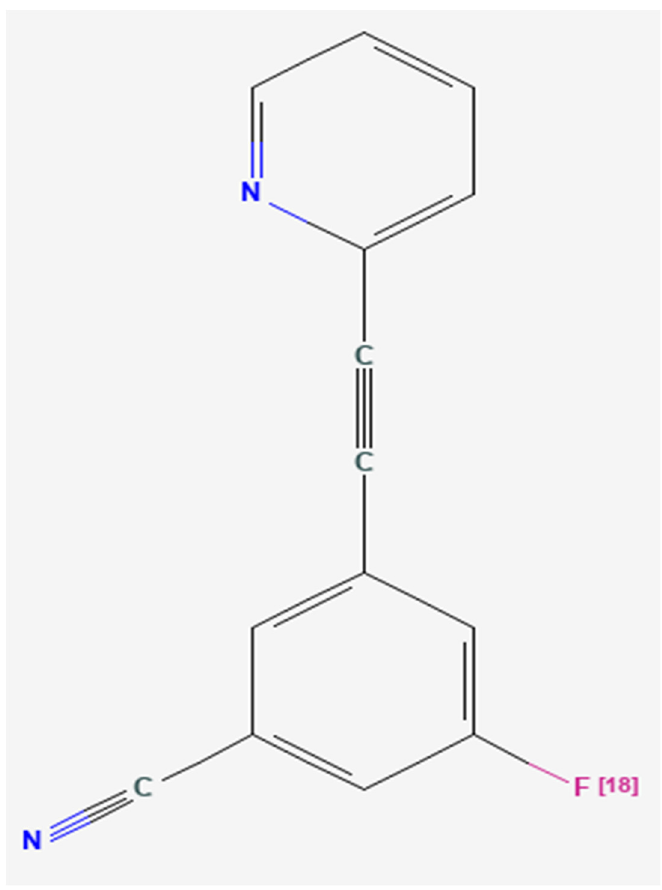
Figure 1. Chemical structure of 3-[ 18 F]fluoro-5-(2-pyridinylethynyl)benzonitrile ([ 18 F]FPEB) [58], a potent, specific inhibitor of the metabotropic glutamate receptor subtype 5 (mGluR 5 ) [60].